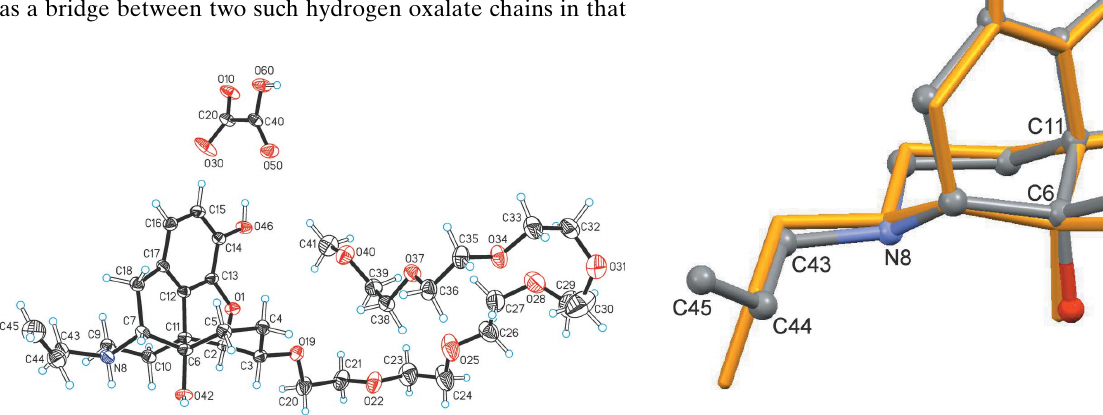
Figure 2 Overlay of the morphine scaffolds of (I) and naloxone hydrochloride dihydrate (Klein et al. , 1987; coloured orange), obtained by least-squares fitting all ring atoms except for (C2–C6/C11).